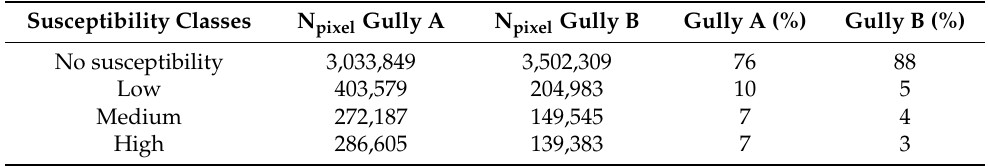
Table 2. Number of pixels for every susceptibility class for the two types of gully